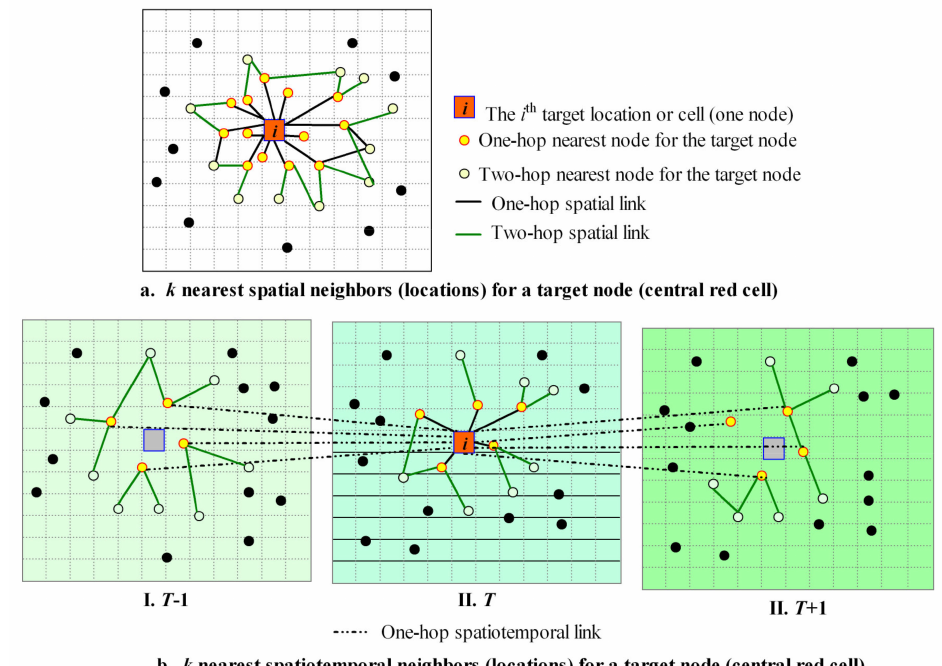
Figure 2. Construction of geographical graph ( a ) and geographical spatiotemporal graph ( b ) using k